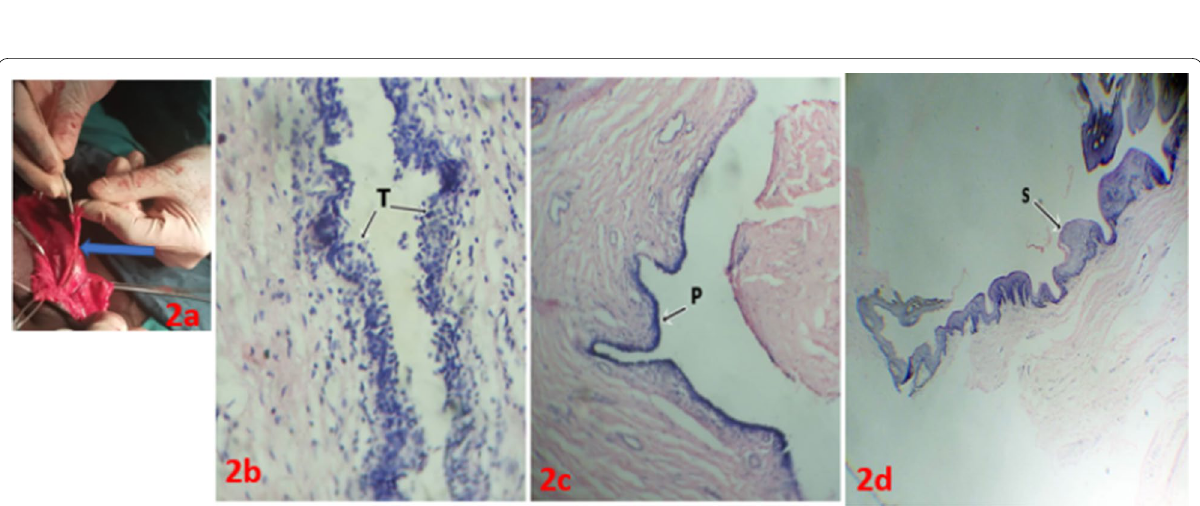
Fig. 2 Intra-op appearance and histologic features of the duplicate dorsal urethra a dorsal urethral tract dissected out {blue arrow}; b transitional epithelium; c pseudostratified epithelium; d squamous